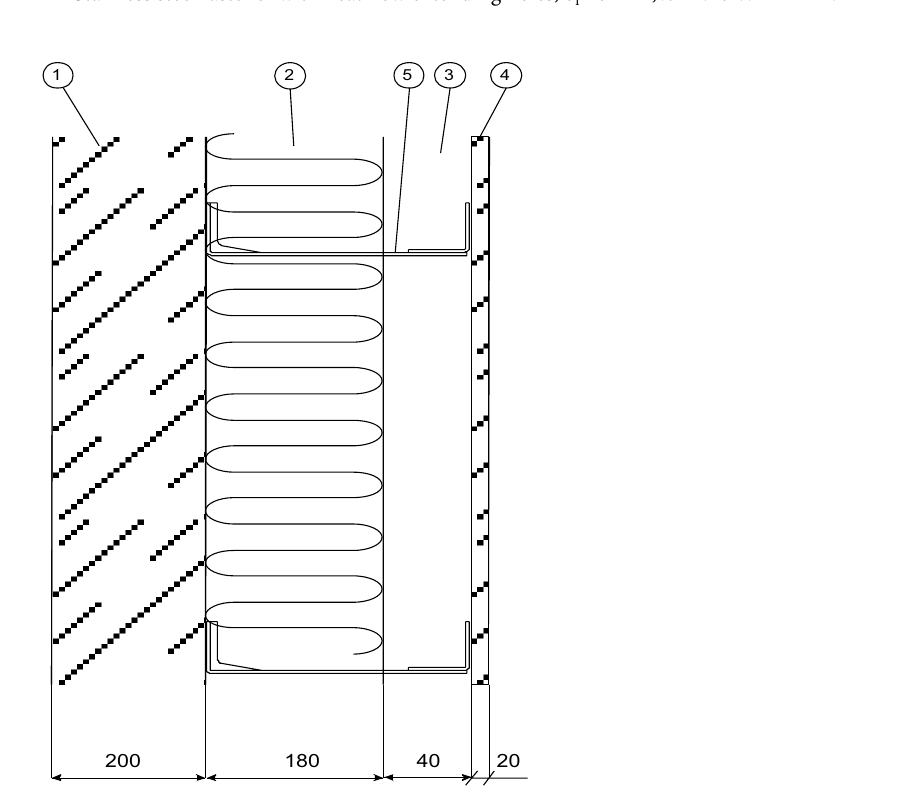
Figure 9. Cross-section of a multilayer wall analyzed via numerical simulation. Denotations: 1—wall (reinforced concrete), 2—insulation (mineral wool), 3—air gap, 4—two variants of external cladding: